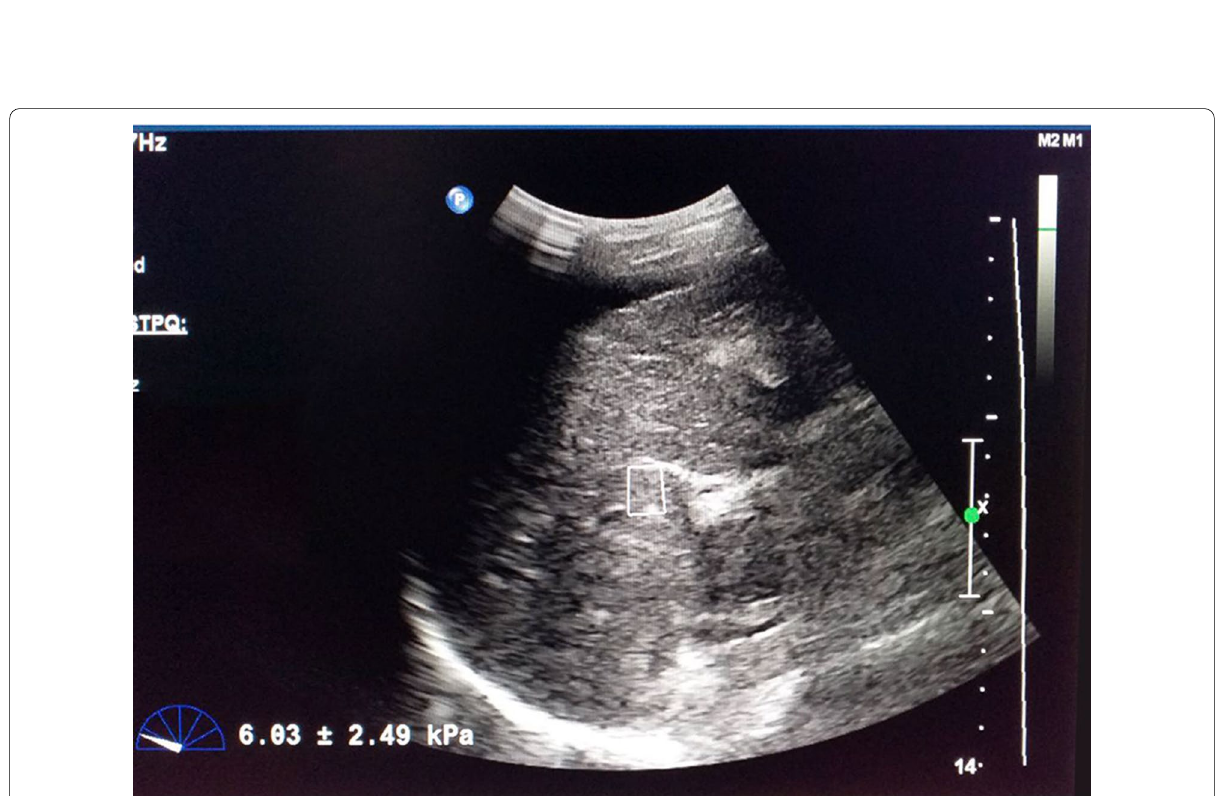
Fig. 3 p-SWE of the liver with ROI on a benign portal vein thrombus (mean